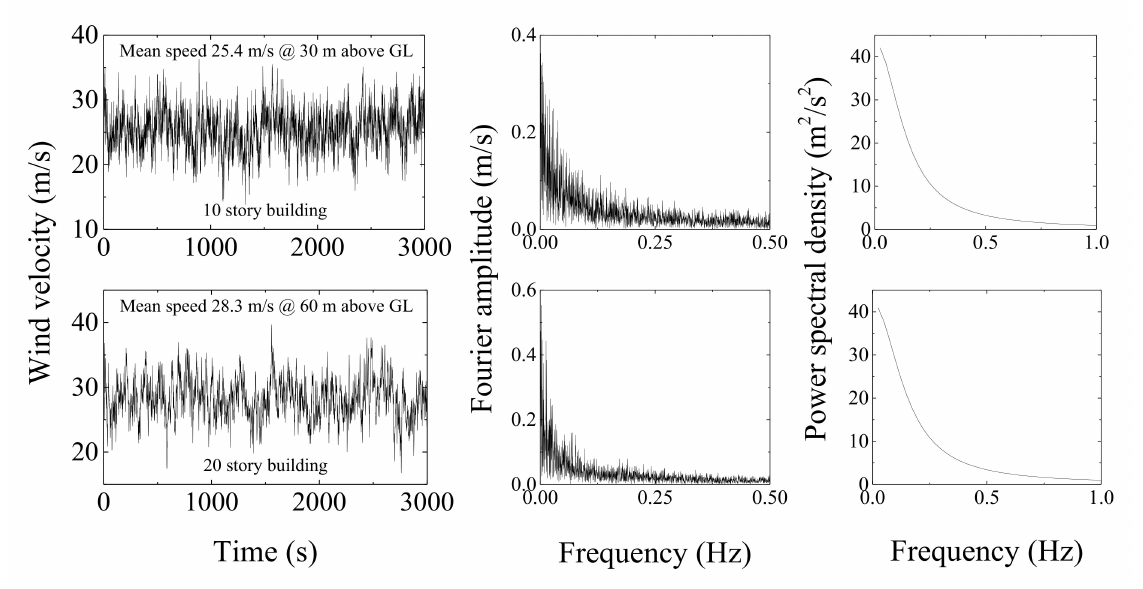
Figure 6. Dynamic wind velocity profile and its characteristics, obtained for wind load case